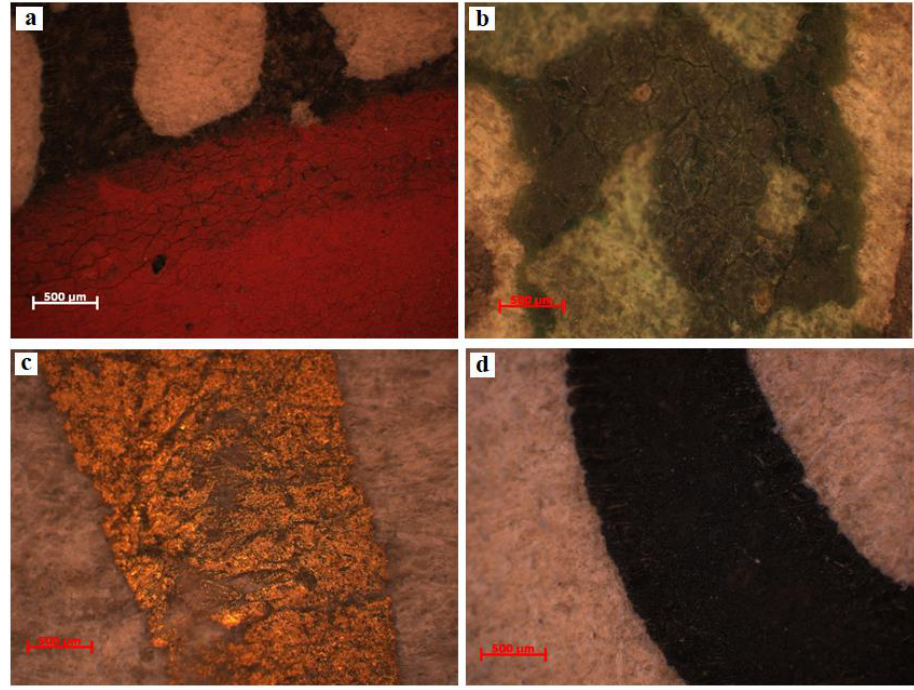
Figure 5. OM images ( × 50) for the writing and miniature inks of document S1: ( a ) S1-PR (red pigment); ( b ) S1-PV (green pigment); ( c ) S1-PA (golden pigment); and ( d ) S1-CN (black pigment).